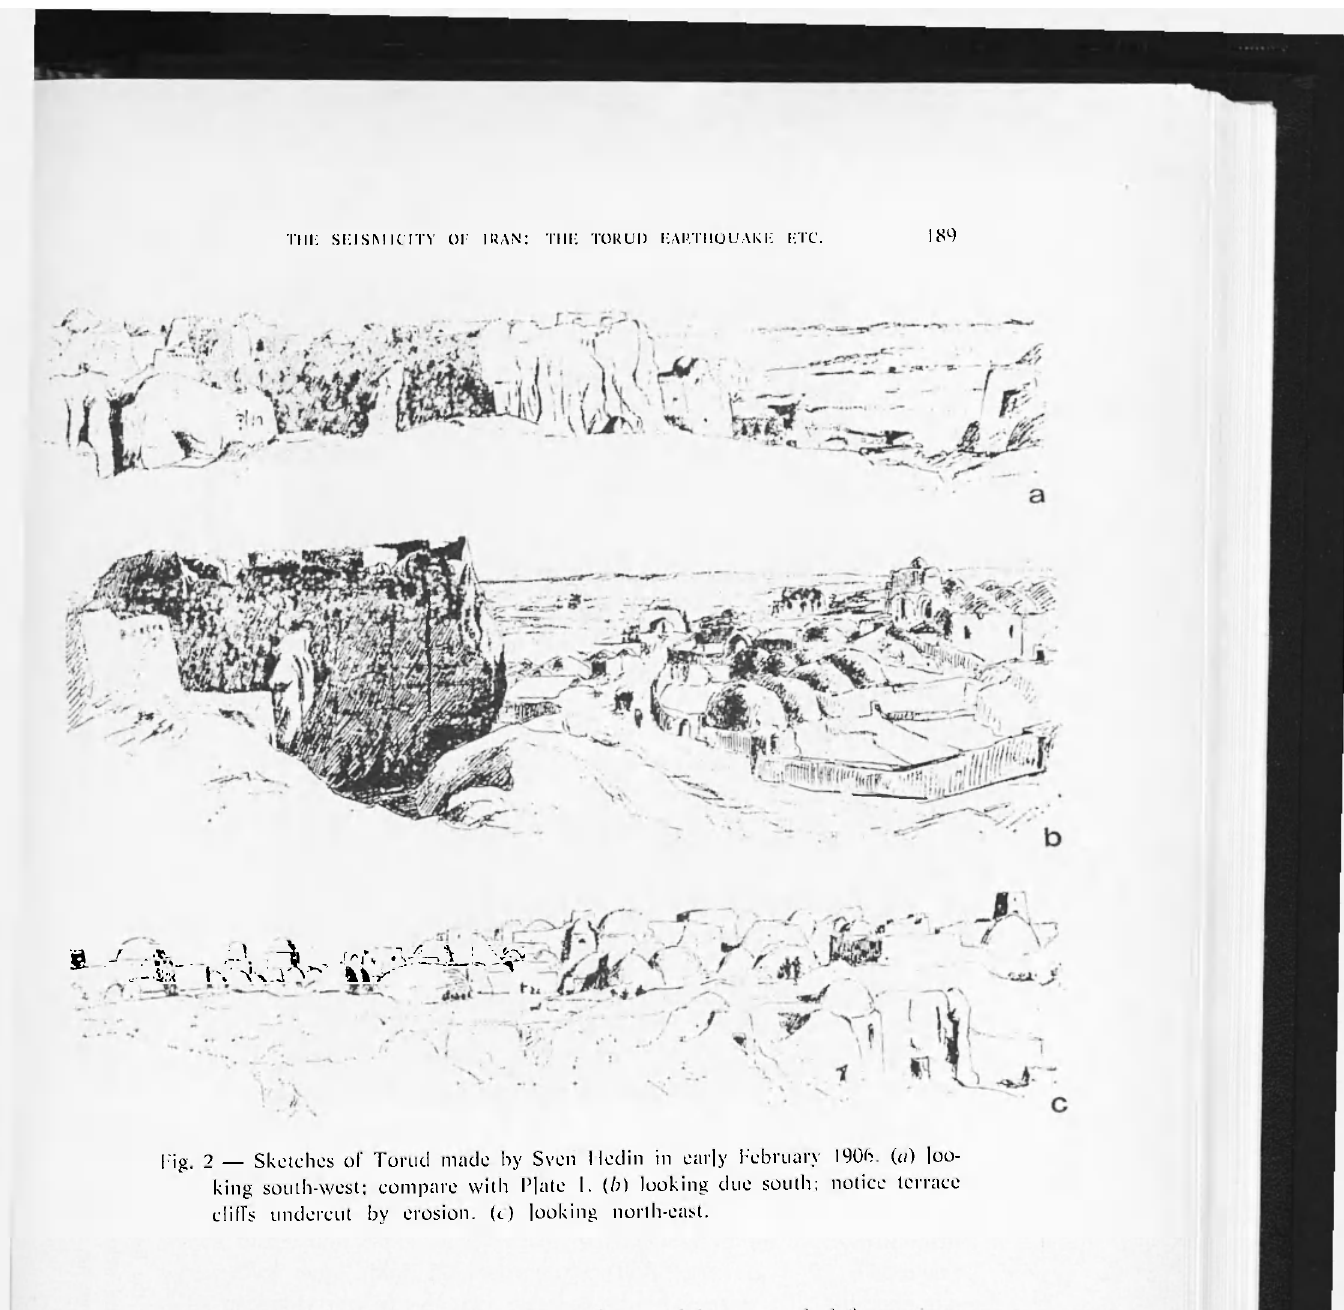
Fig. 2 — Sketches of Torud made by Sveri Hedin in early February 1906. (a) loo- king south-west; compare with Plate 1. (fa) looking due south: notice terrace cliffs undercut by erosion, (t) looking